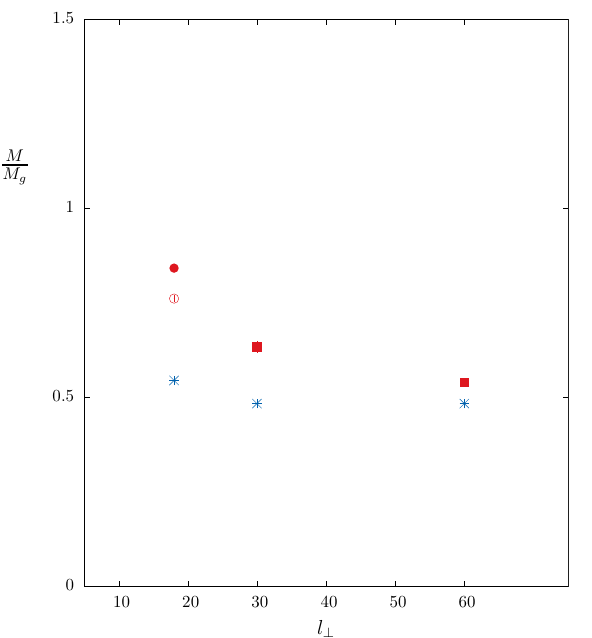
Figure 5 . At (cid:12) = 7 : 0 in SO(3) for our shortest (cid:13)ux tube, l = 18: variation of lightest masses as a function of the transverse spatial size, l ? , in units of the in(cid:12)nite volume mass gap M g . For l ? = 18 the lightest J P = 0 + ( (cid:15) ) and J P = 2 + ( (cid:14) ) masses are shown, and for l ? > 18 we show the mass